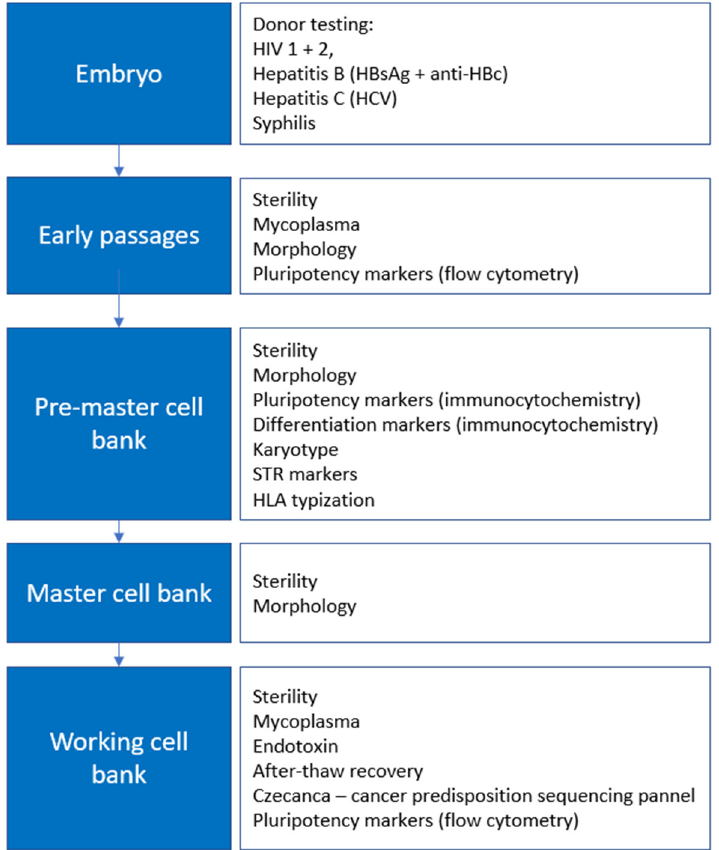
Figure 1. Manufacture scheme: banking of pre-master cell bank, master cell bank, and working cell bank.